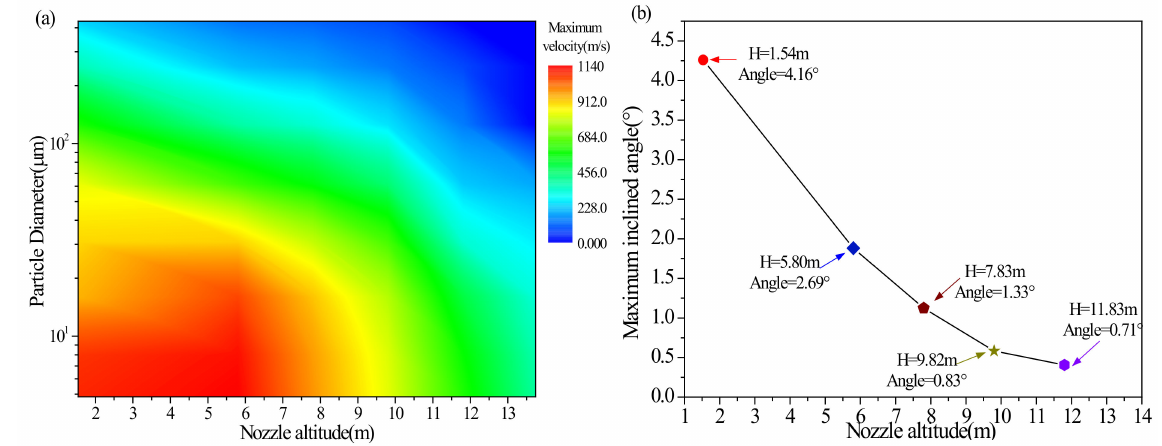
Figure 9. Lunar dust particle maximum velocity contour and inclined angle for different